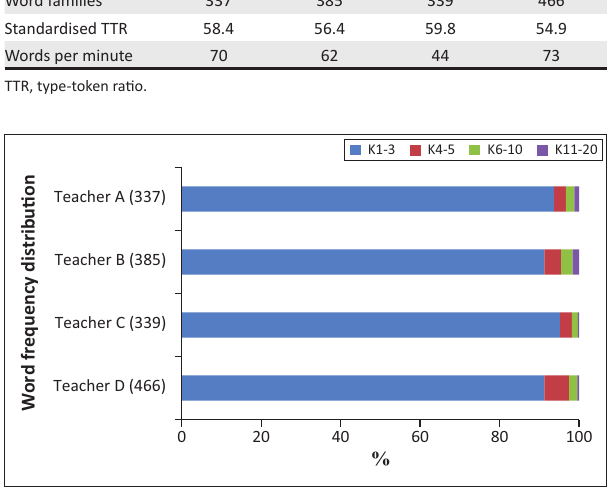
FIGURE 2: Word frequency distribution per teacher (total word families).